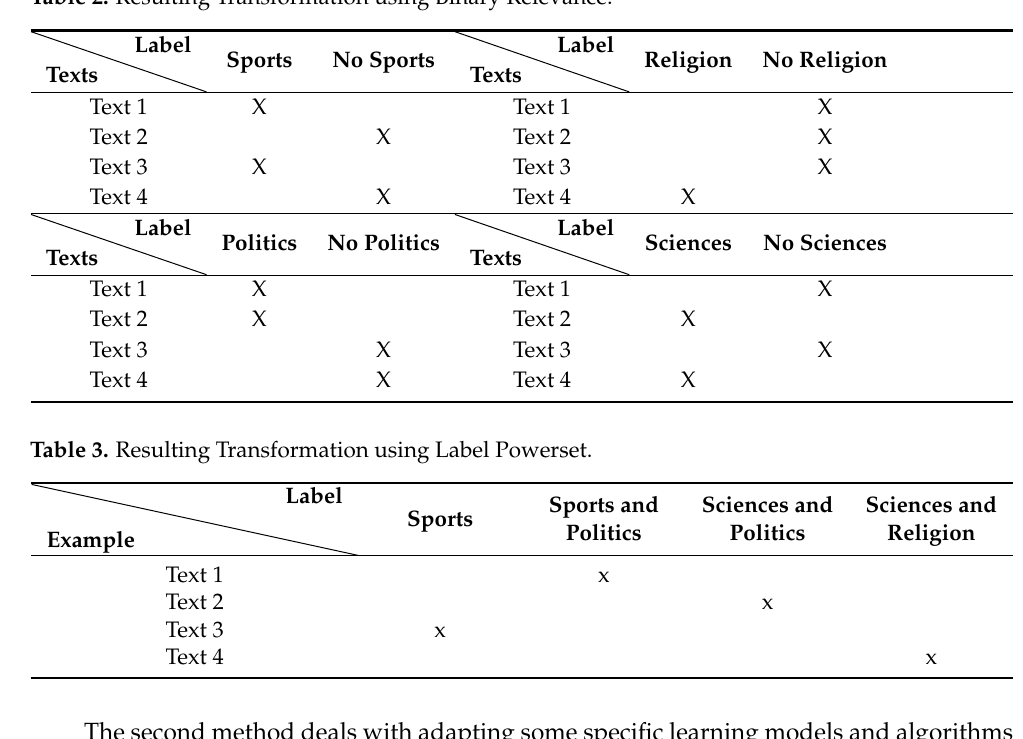
Table 2. Resulting Transformation using Binary Relevance.